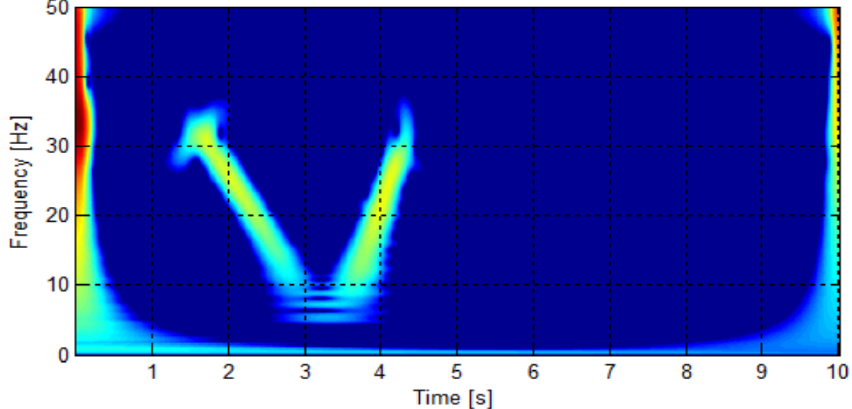
Figure 6. Reassigned scalogram of the LSHst in the simulated machine, in the time-frequency